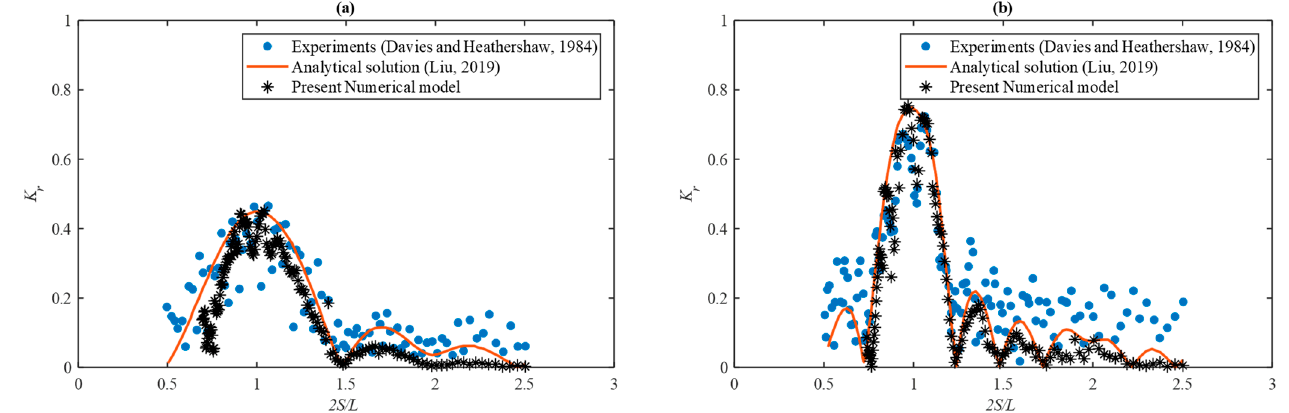
Figure 2. Validation of the present numerical model with experiment [12] and analytical solution [3] data. ( a ) 𝑁 = 2 ( b ) 𝑁 = 4 .